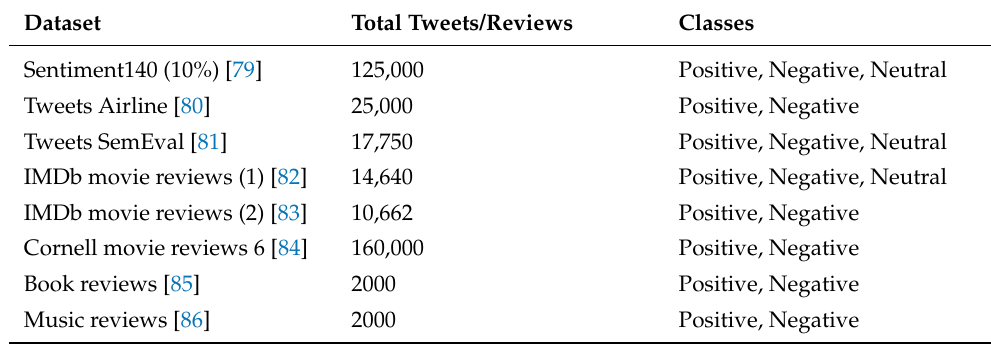
Table 5. Dataset